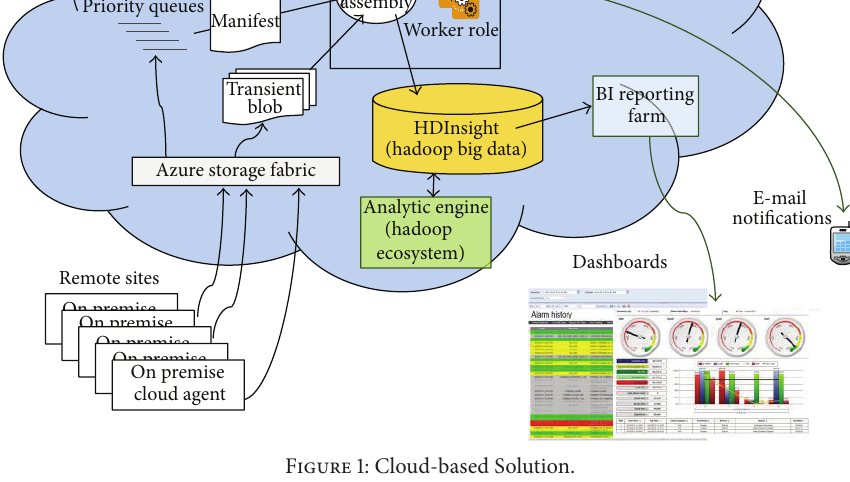
Figure 1: Cloud-based Solution.